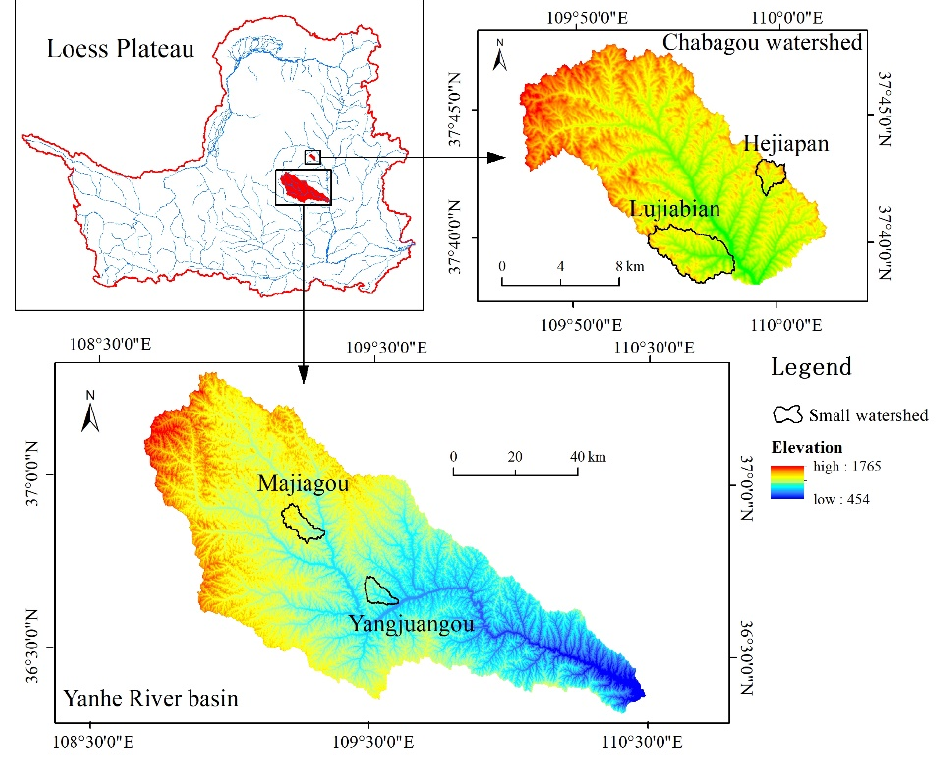
Figure 1. Location of small watersheds.